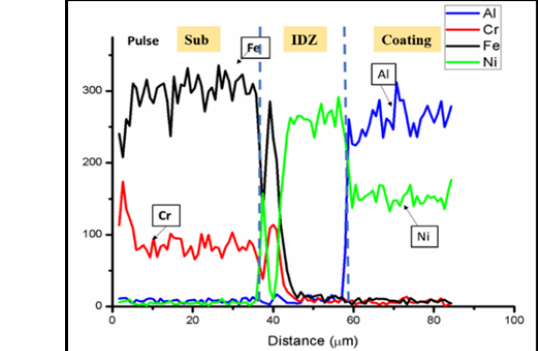
Figure 3. Cross-sections of AISI 304L coated substrates exhibiting coating layer by ( a ) cross-section taken by optical microscopy at 50X and ( b ) the SEM micrograph, which exhibits the outer layer and interdiffusion zone that are characteristic features of typical aluminide coating.